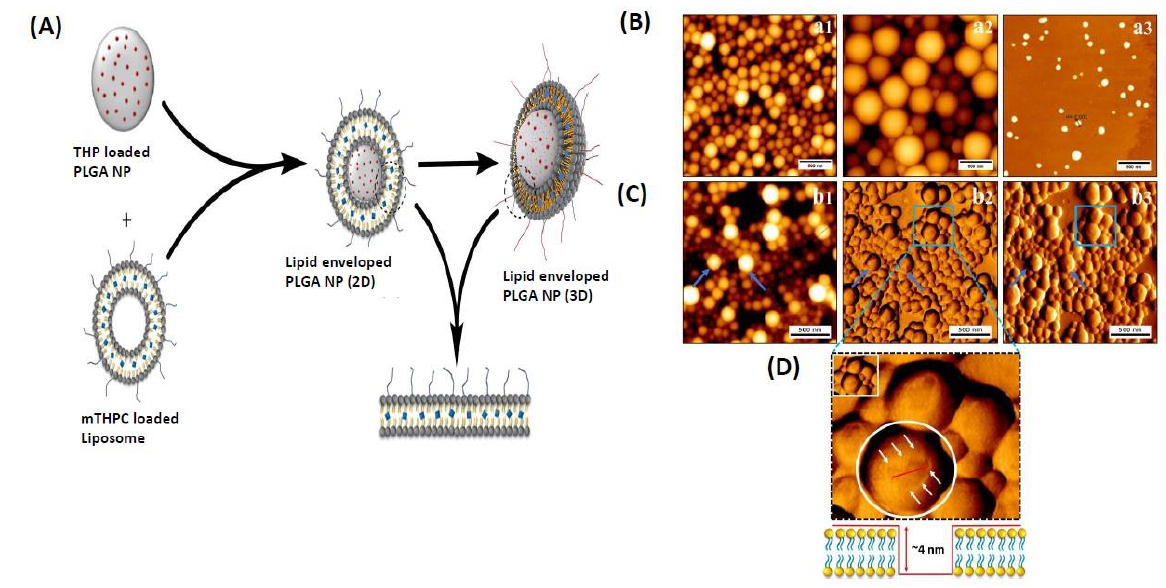
Figure 4. Biodegradable nanoparticles with lipid bilayers are shown schematically in ( A ). Morphology of the surface depicted in ( B – D ). ( A ) AFM imaging of THP-NP 200 nm, THP-NP 400 nm, and mTHPC-LP. AFM micrographs of lipid-coated nanoparticles are shown in panel ( B ). (a1) THP NP 200 nm; (a2) THP NP 400 nm and (a3) mTHPC-LP using AFM. Lock-in amplitude view, lock-in phase view, and height measured view. Lipoparticle thickness around PLGA nanoparticles is seen in ( C ) using an AFM cross-sectional profile. (b1) height measured view; (b2) lock-in amplitude view and (b3) lock-in phase view. The bar’s width corresponds to 500 nm. The figure is adapted from [71] with copyright permission. Table 2. Some examples of preclinical studies of PLGA-based nanomaterial therapy that has been used as anticancer delivery